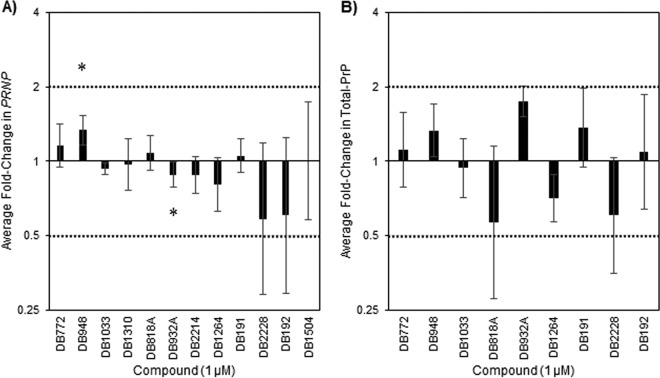
Prion protein expression is not inhibited by preliminary hit DB compounds. The effects of preliminary hit DB compounds on PRNP transcript levels (A) and total PrP (B) were evaluated. (A) RNA was collected from treated cells and tested by qRT-PCR for PRNP transcript levels. PRNP transcripts were normalized to GAPDH transcript and compared to the vehicle control. (B) Total protein was collected from treated cells and tested for total PrPC using a commercial ELISA. Total PrP was normalized to the vehicle control. Columns represent the fold change in PRNP transcripts or total PrP. Increasing bars indicate compound enhancement, and decreasing bars indicate compound inhibition. Fold change values were statistically compared to the vehicle control using individual t tests (*, P < 0.05). The y axis reference lines indicate the established 2-fold cutoff level for biologically significant inhibition or enhancement. Error bars represent the 95% confidence intervals from the mean fold change from at least 3 independent experiments.